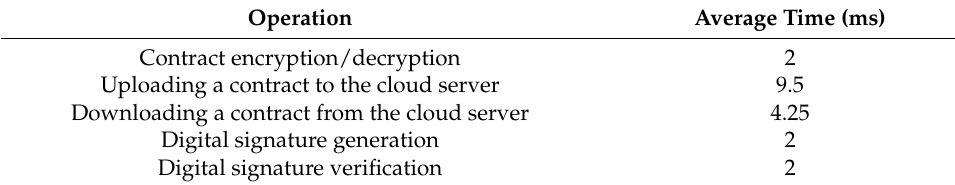
Table 5. The average time of each operation performed by PTEC .